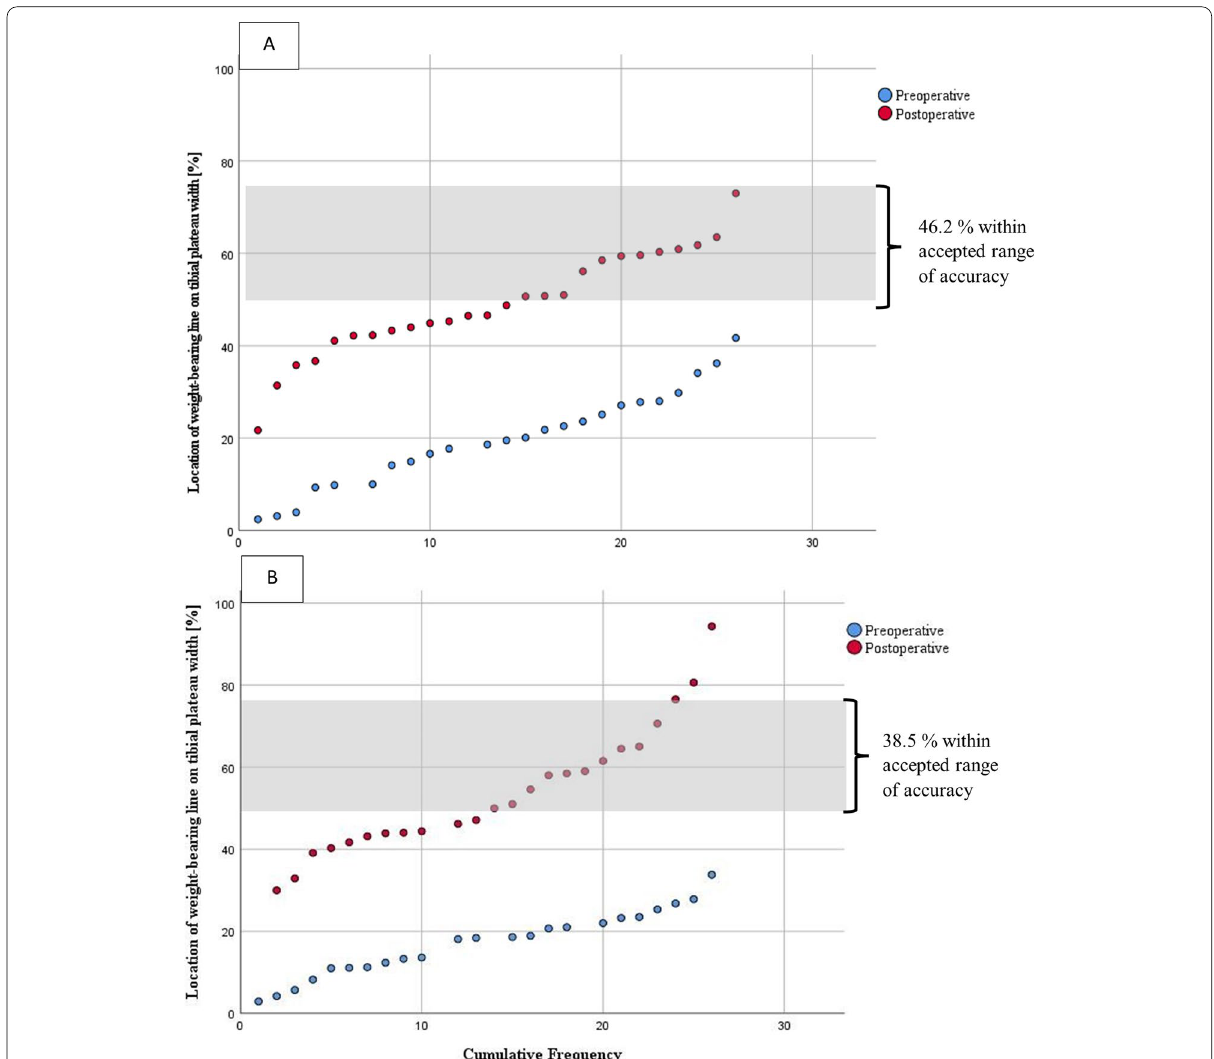
Fig. 2 Cumulative frequency of the pre- and postoperative weight-bearing lines for the Noyes group ( A ) and Conventional-Group ( B ). The bar represents the accepted range of accuracy which corresponds to the 50–75% area of the tibial plateau